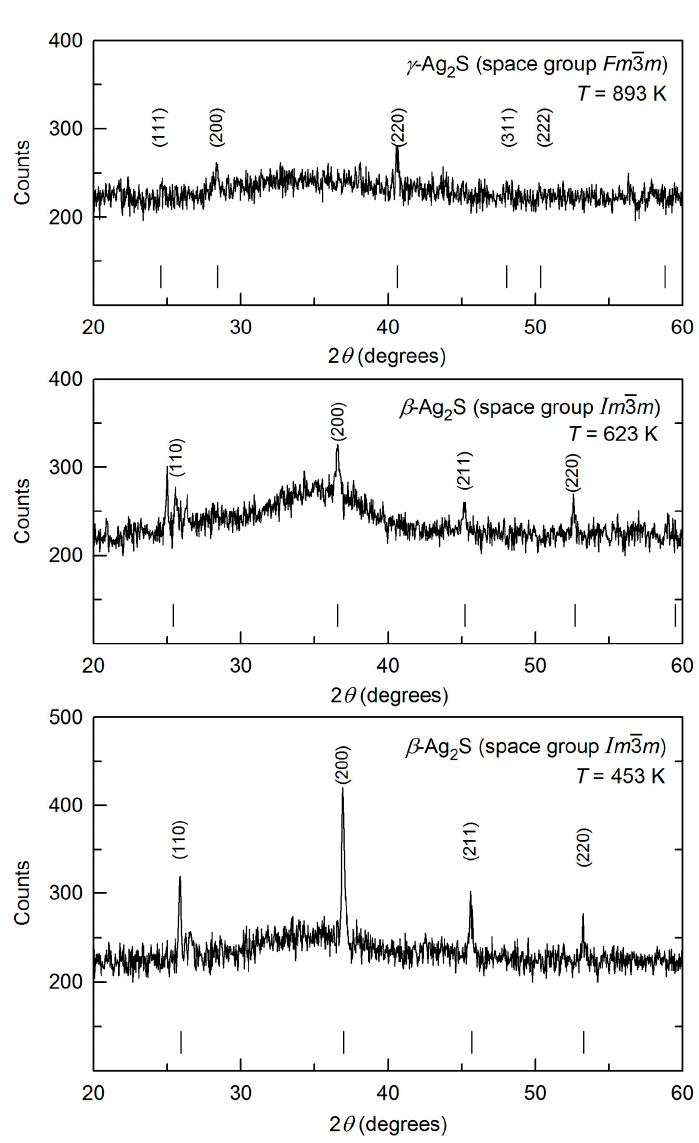
Figure 7. XRD patterns of superionic β -Ag 2 S and γ -Ag 2 S phases at temperatures of 453, 623, and 893 K. In XRD patterns of argentite at temperature 453 and 623 K, along with diffraction reflections of cubic β -Ag 2 S, diffuse reflection in the region 2 θ ≈ 30.0–31.0° and a wide diffuse halo in the region 2 θ ≈ 34-40° are observed (see Figure 7). The intensity of argen- tite reflections decreases with increasing temperature, while the intensity of the diffuse halo increases. In the XRD pattern of γ -Ag 2 S phase at 893 K, there is a wide diffuse halo in